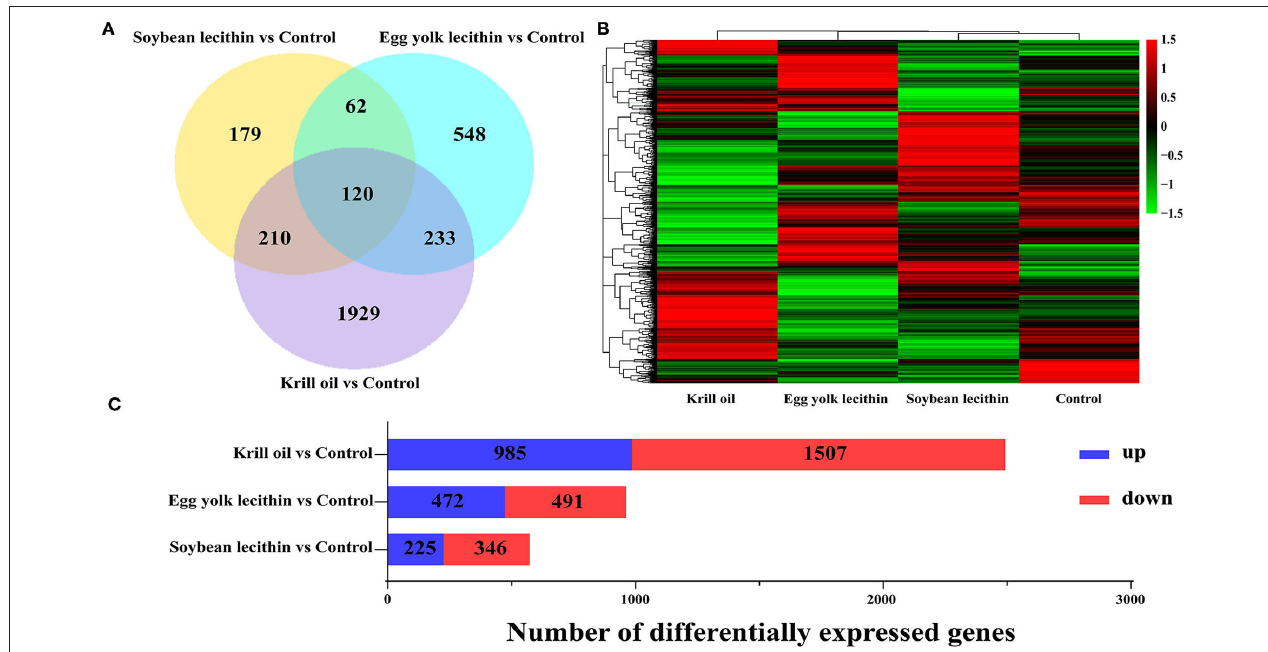
FIGURE 8 | Statistics of differentially expressed genes fed with different phospholipid ovaries. (A) Venn plot of differentially expressed genes at the comparison between each treatment group and the control group. (B) Gene expression pattern clustering heatmap. Each column in the figure represents a sample, and each row represents a gene. The color in the figure represents the expression value of the gene after standardized treatment in each sample. Red represents a higher expression level of the gene in the sample, and green represents a lower expression. (C) The number of up and downregulated differentially expressed genes were identified at the comparison between each treatment and the control.